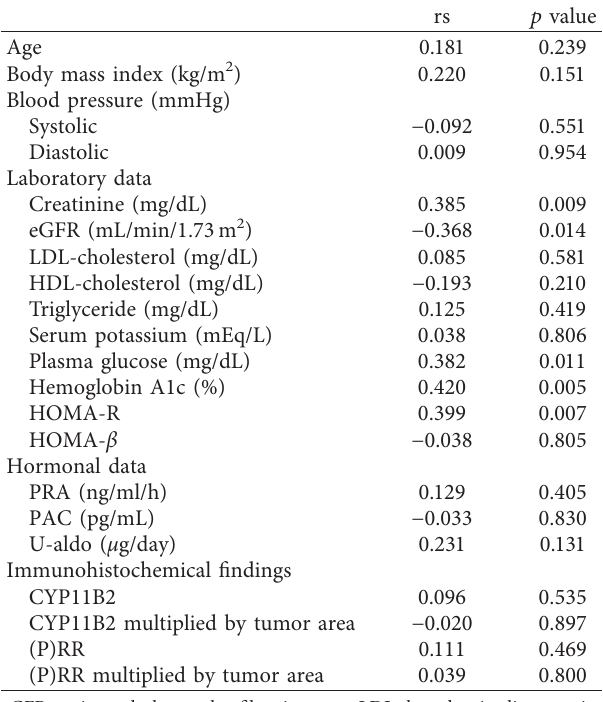
Table 3: Single correlation analyses with serum soluble (pro)renin receptor levels in the pathologically confirmed aldosterone-pro- ducing adenoma